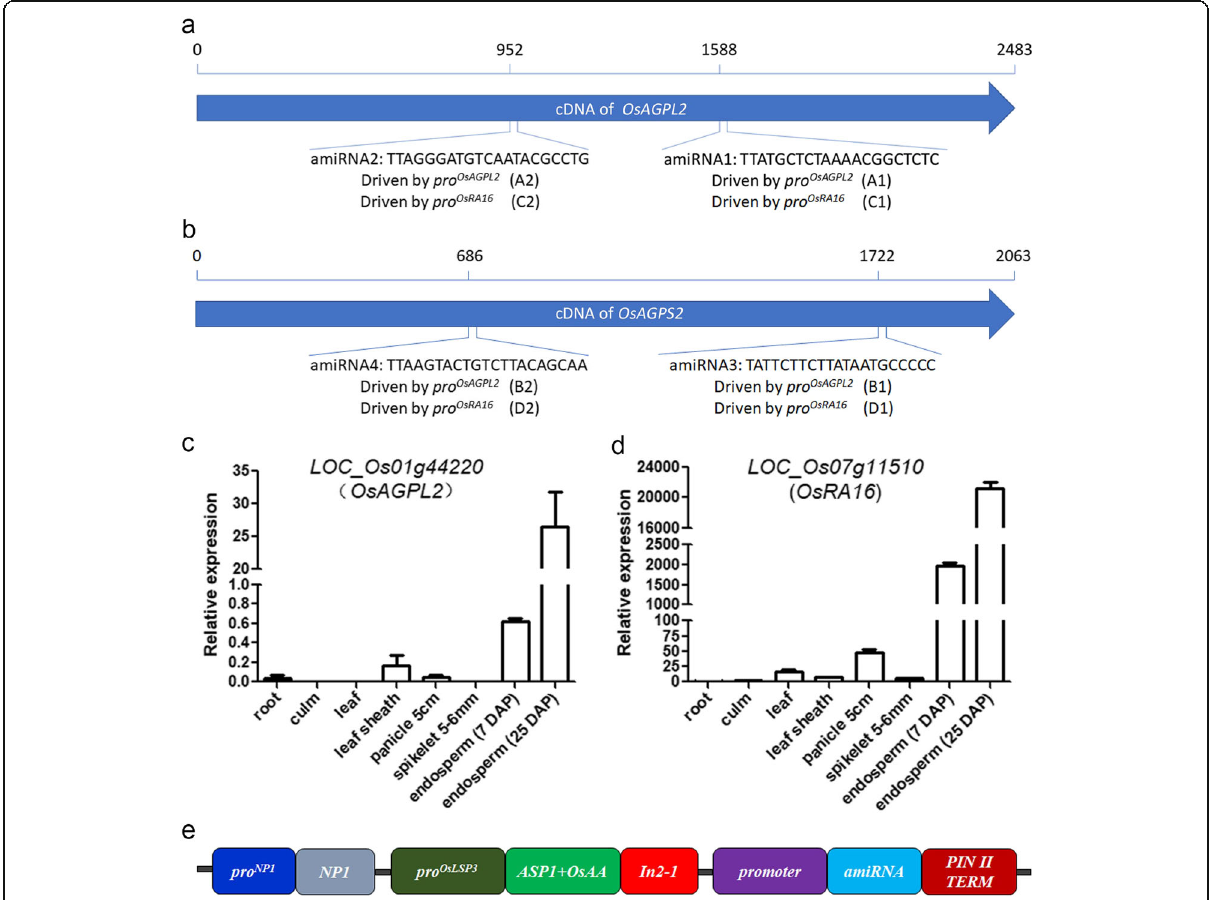
Fig. 1 Design of the weight-based seed sorting system. ( a, b ) Target sites and the corresponding amiRNA sequences for silencing OsAGPL2 ( a ) and OsAGPS2 ( b ). Each amiRNA gene was driven by OsAGPL2 promoter ( pro OsAGPL2 ) and OsRA16 promoter ( pro OsRA16 ). The eight constructs were named as A1, A2, B1, B2, C1, C2, D1, and D2. ( c, d ) The spatial expression patterns of OsAGPL2 ( c ) and OsRA16 ( d ). The gene expression levels were determined by qRT-PCR with Actin gene as internal control. Data are shown as means ± SD (n = 3). DAP, day after pollination. ( e ) Diagram showing the three function modules. Pro OsNP1 -Os NP1 is for fertility restoration, pro OsLSP3 - ASP1 + OsAA - In2-1 is for pollen inactivation, and promoter- amiRNA - PINII TERM is for silencing OsAGPL2 or OsAGPS2 gene. In2-1 and PINII TERM are transcriptional terminators of the maize In2-1 gene and the potato PINII ( Proteinase Inhibitor II ) gene, respectively (Chang et al.